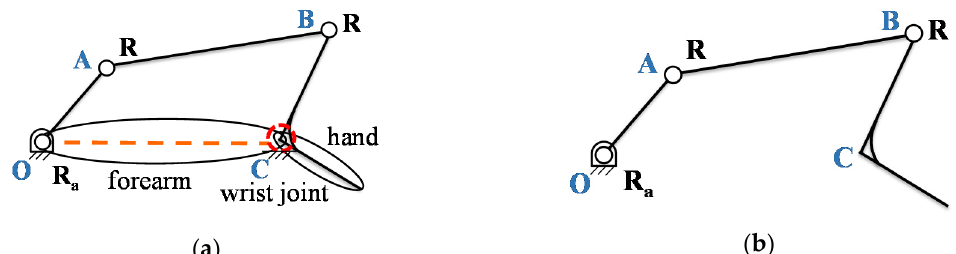
Figure 3. Analytical model of RRRR four-bar linkage.